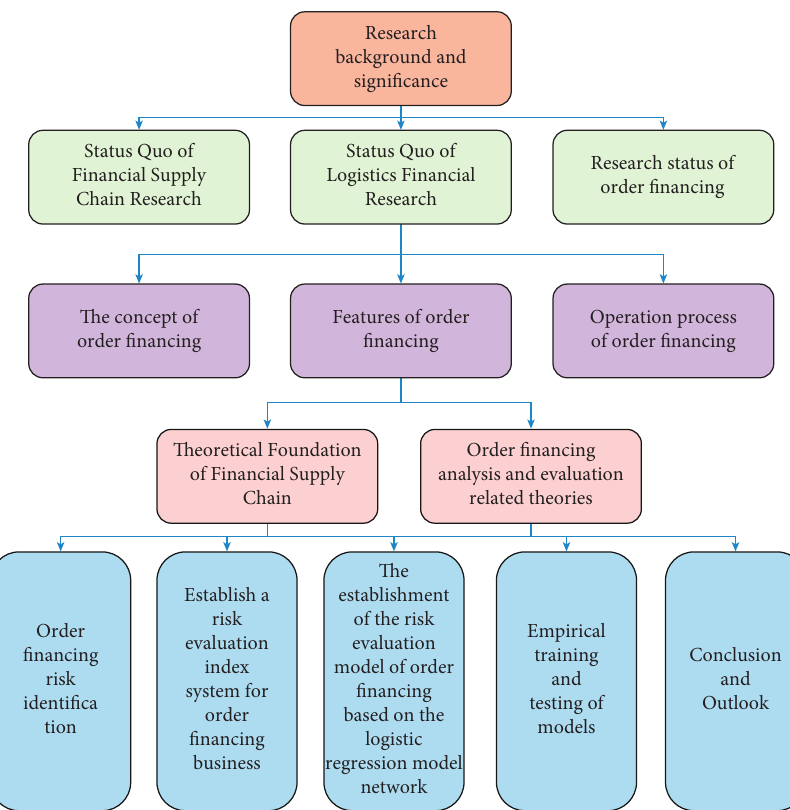
Figure 1: The structure of the financial supply chain